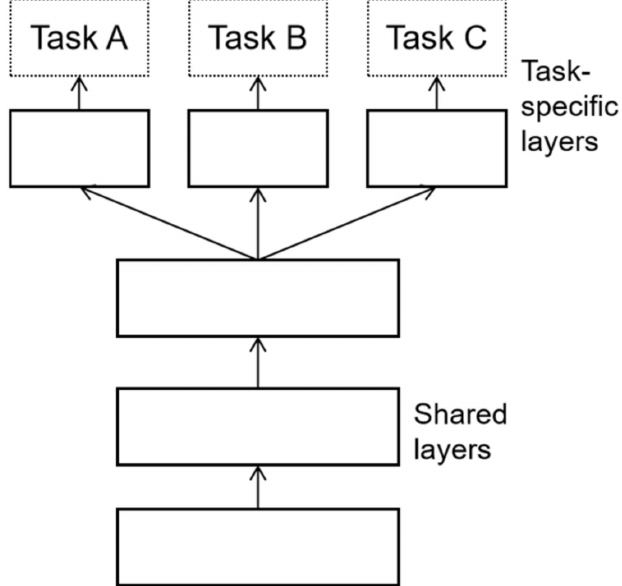
Figure 2. The hard parameter sharing